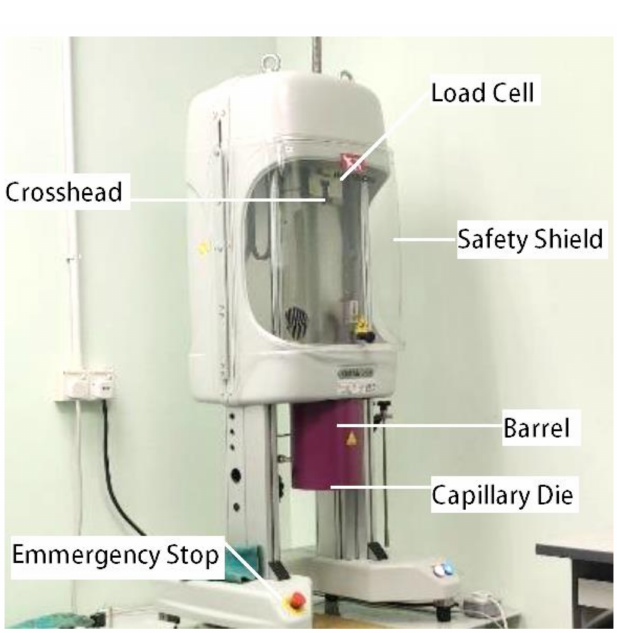
Figure 4. The capillary rheometer used (model Instron SR20).